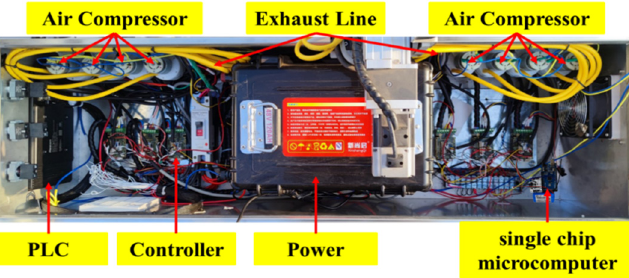
Figure 22. Control system hardware module.